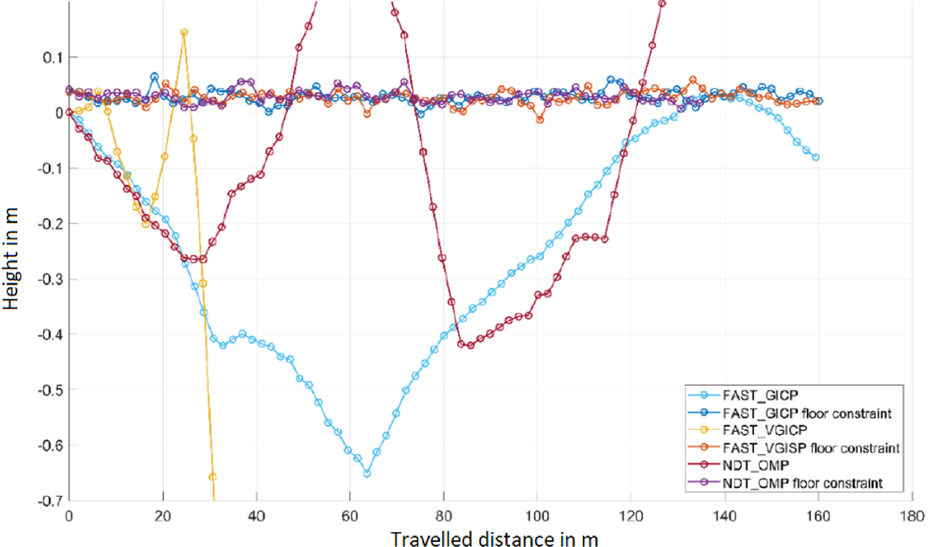
Figure 7. Height profile as a function of the distance covered in the corridor of the B-building of Offenburg University with and without floor constraint.